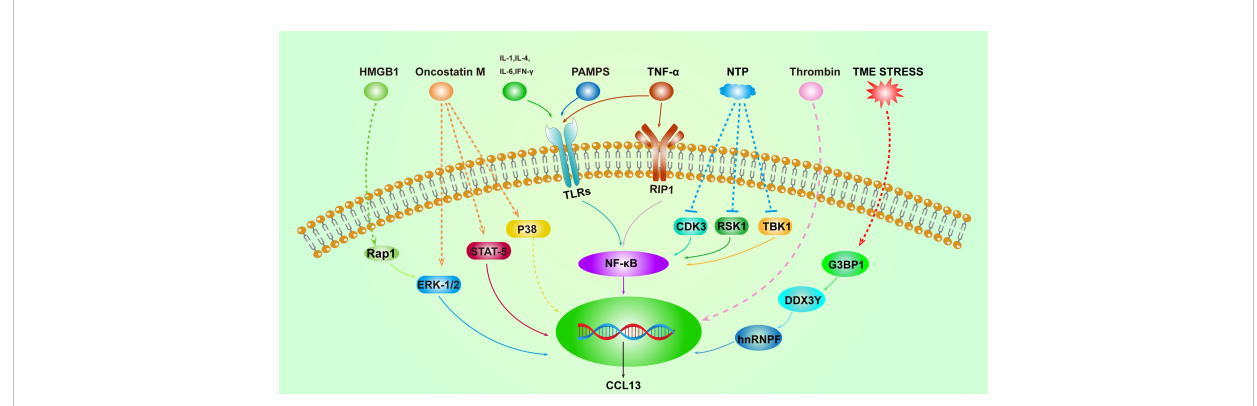
FIGURE 2 Overview of the activation pathways of CCL13. Solid lines represent well-de fi ned relationships, and dashed lines represent intermediate molecular mechanisms unknown. High mobility group box 1 (HMGB1), Ras-Associated Protein 1 (Rap1), the tumor micro-environment (TME), and non-thermal plasma (NTP).